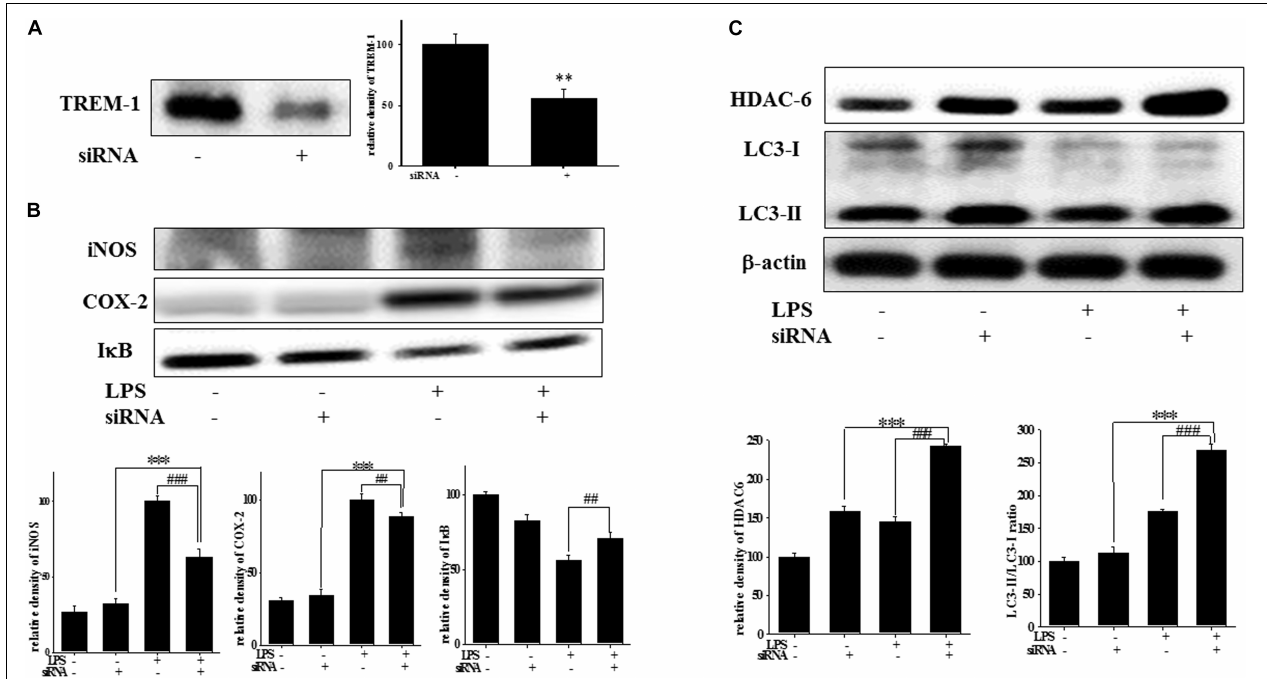
FIGURE 4 | TREM-1 knockdown in BV2 cells decreased TREM-1 expression levels and the LPS-induced upregulation of iNOS, COX-2, and I κ B expression and increased HDAC6 expression and the LC3-II/LC3-I ratio. (A) Western blot analysis of TREM-1 expression in the control siRNA and TREM-1 siRNA groups for 7 h ( n = 4/group). The results demonstrate that the transfection of TREM-1 siRNA significantly attenuated the expression of TREM-1. (B) Western blot analysis for iNOS, COX-2, and I κ B expression in TREM-1 knockdown BV2 cells in the control (control siRNA), LPS-treated (control siRNA), control (TREM-1 siRNA), and LPS-treated (TREM-1 siRNA) groups after treatment with 100 ng/ml LPS for 16 h ( n = 4/group). The knockdown of TREM-1 in BV2 cells attenuated the LPS-induced upregulation of iNOS and COX-2 and reversed the LPS-induced downregulation of I κ B expression. (C) Western blot analysis for HDAC-6 expression and LC3-II/LC3-I ratio in TREM-1 knockdown BV2 cells in the control (control siRNA), LPS-treated (control siRNA), control (TREM-1 siRNA), and LPS-treated (TREM-1 siRNA) groups after treatment with 100 ng/ml LPS for 16 h ( n = 4/group). Knockdown of TREM-1 also enhanced the LPS-induced upregulation of HDAC6 and increased the LC3-II/LC3-I ratio. “–” represents control siRNA and “+” represents TREM-1 siRNA. The bars represent means ± SEM. ∗∗∗ P < 0.001 versus the control group (TREM-1 siRNA); ## P < 0.05 versus the LPS group (control siRNA); ### P < 0.001 versus the LPS group (control